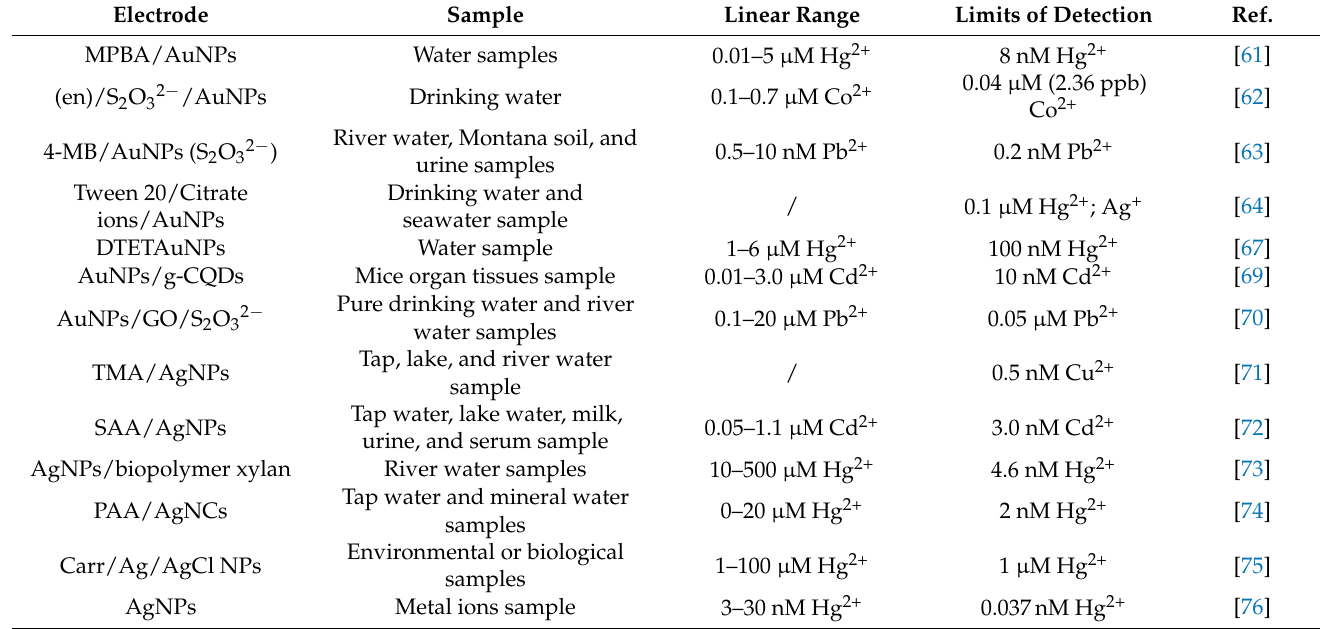
Table 3. Representative studies of colorimetric analysis of heavy metals from food and water resources based on nanoparti- cle